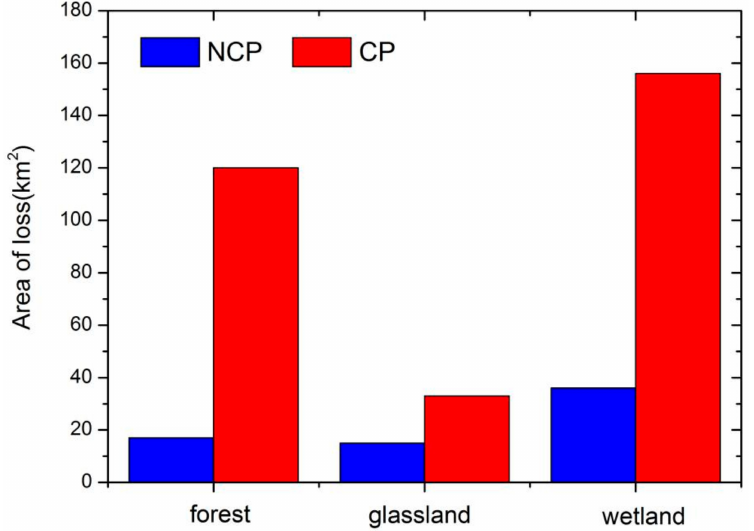
Figure 4. Loss of each ecological land type during 2010–2020 in NCP and CP